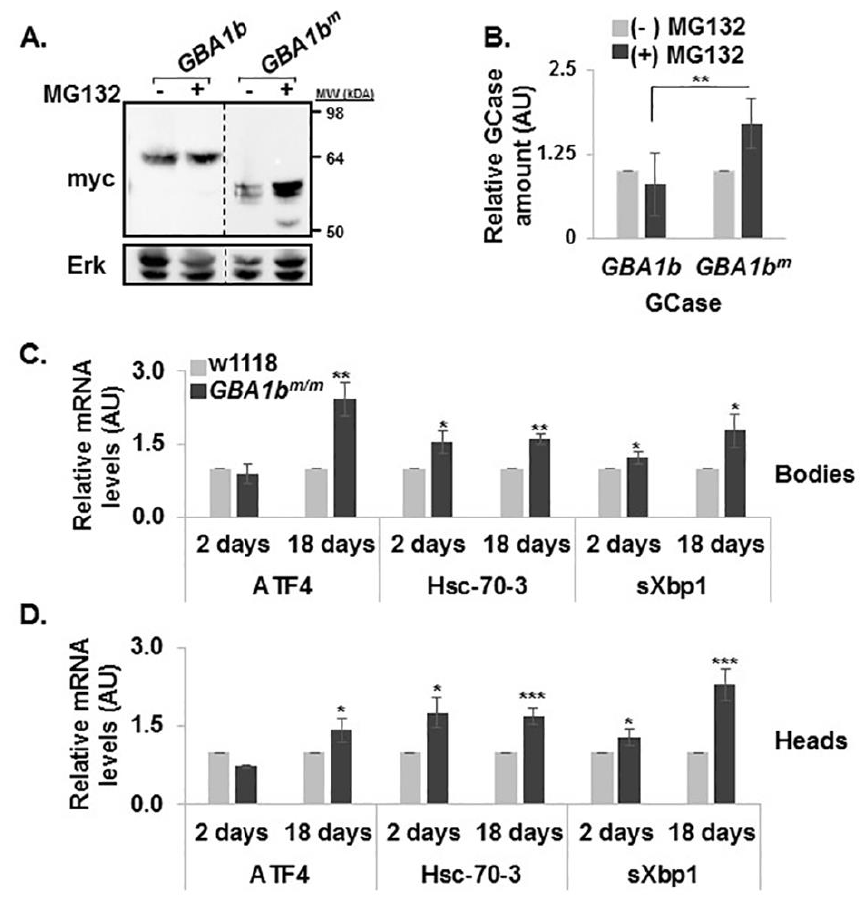
Figure 5. ERAD and UPR activation in GBA1b m/m flies. ( A ) Protein lysates prepared from HEK293T cells, transfected with plasmids expressing normal or mutant GBA1b- encoded proteins (mycHispcDNA GBA1b - GBA1b , mycHispcDNA GBA1b m -GBA1b m ), were treated or untreated for 18 h with MG132. The corresponding blot was interacted with anti-myc and anti-Erk antibodies. ( B ) To quantify the results, WT and mutant myc- GBA1b intensity was divided by that of Erk in the same lane, and the number obtained for GBA1b without treatment was considered 1. The results represent the mean ± standard error of three independent experiments. ( C , D ) mRNA levels of UPR markers: activating transcription factor 4 (ATF4), Heat shock-70-3 (HSC-70-3) and spliced x-box binding protein (sXBP1), in bodies ( C ) and heads ( D ) of control (w1118), and GBA1b m / m flies at 2 and 18 days post-eclosion, as analyzed by qRT-PCR. mRNA level of each marker was normalized to that of RP49. mRNA levels of the different tested genes in control flies were considered 1. * p < 0.05, ** p < 0.01, *** p < 0.005. Table 2. Panther gene ontology analysis of fly bodies. Gene ontology enrichment analysis of genes upregulated in bodies of GBA1b m / m flies in comparison to age matched controls. Hyper genomic test was used for the calculation of fold enrichment.